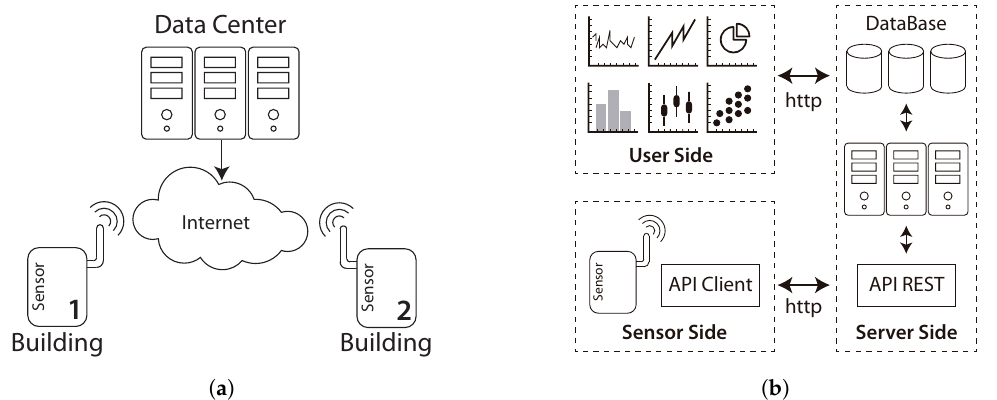
Figure 3. Communication and data flow of our system: ( a ) Global view of the WSN; ( b ) basic data flow of the